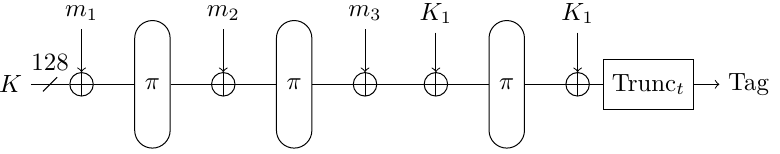
Figure 4: Chaskey mode for a message of 3 blocks.